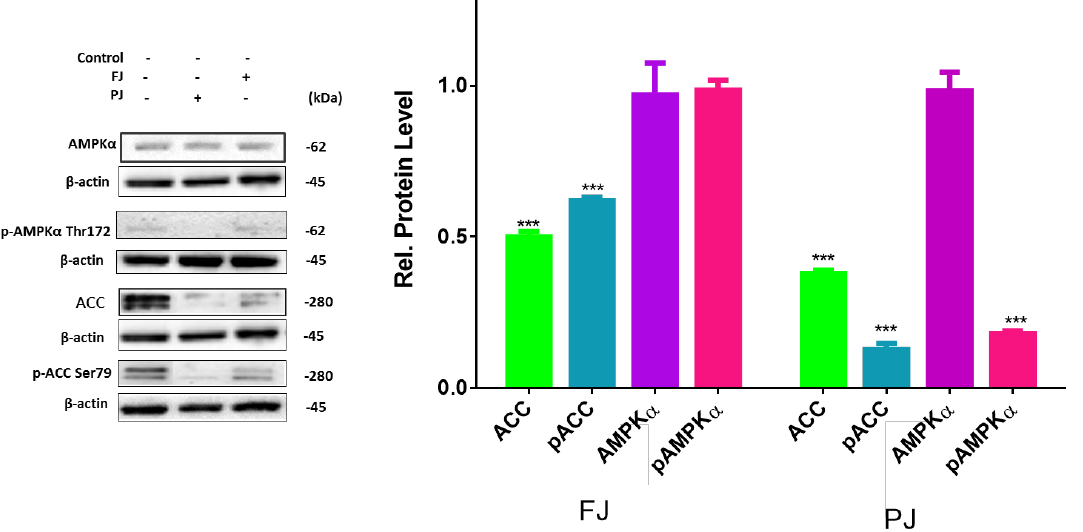
Figure 9. Effect of V. opulus FJ and PJ preparations on the relative levels of phosphorylated proteins involved in adipogenesis determined by Western blot analysis in differentiated 3T3-L1 cells. Control cells were not exposed to any compound; values are means ± standard deviations, n ≥ 4; statistical significance was calculated between treatment and control cells (untreated) with *** p ≤ 0.001.